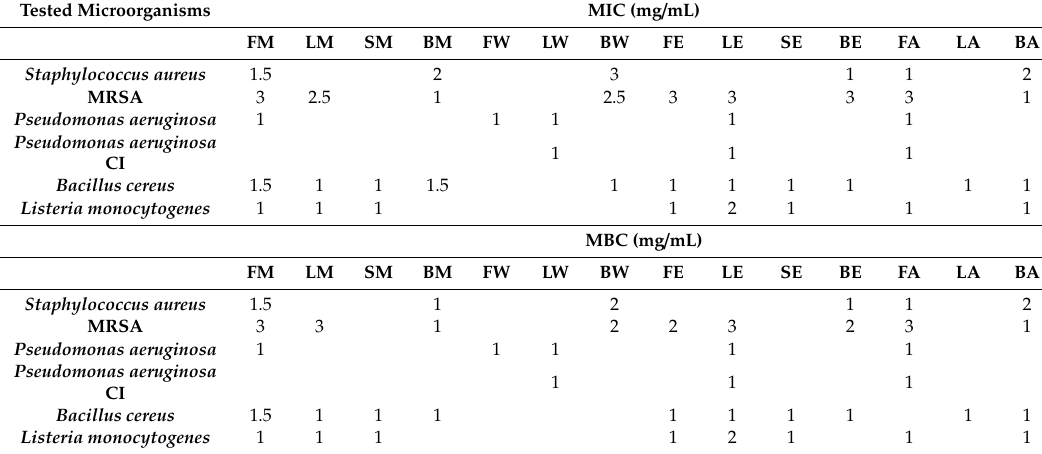
Table 6. The minimum inhibitory concentration (MIC) and minimum bactericidal concentration (MBC) of the extracts of T. ferdinandiana